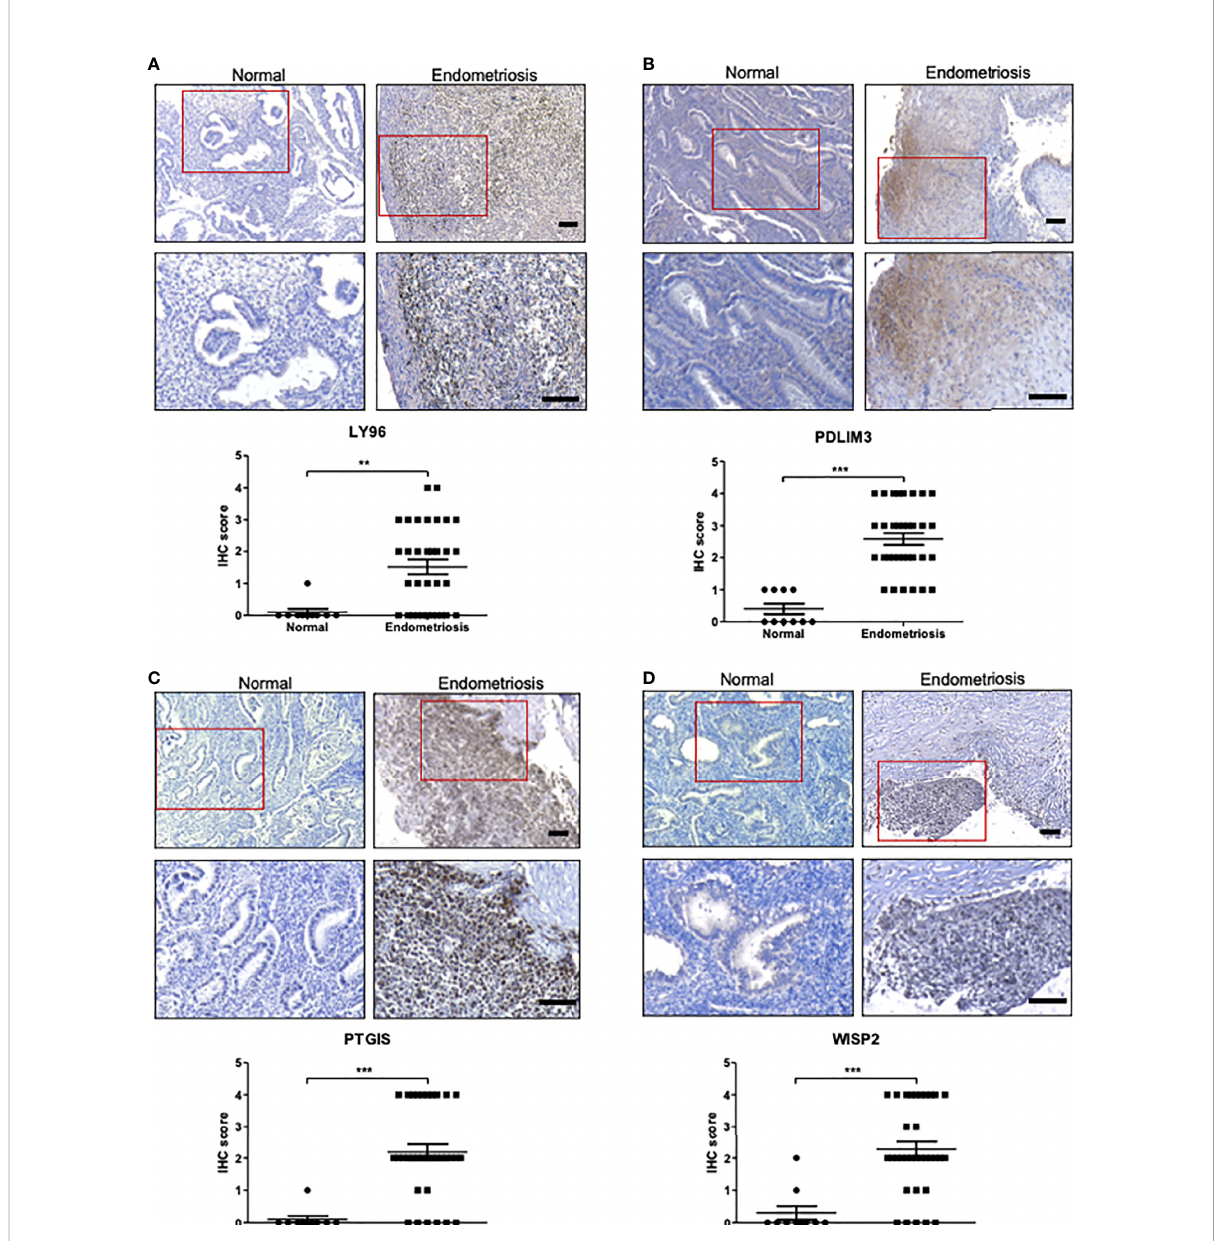
FIGURE 5 The protein expression of LY96, PDLIM3, PTGIS, and WISP2 in endometriosis tissue. (A – D) The protein expression of (A) LY96, (B) PDLIM3, (C) PTGIS, and (D) WISP2 was measured by IHC analysis of endometrial tissues from healthy volunteers or endometriosis patients. The representative IHC images are shown in upper panel (bar = 100 m m). The graphs in lower panel represent IHC score. ** p < 0.01 and *** p <